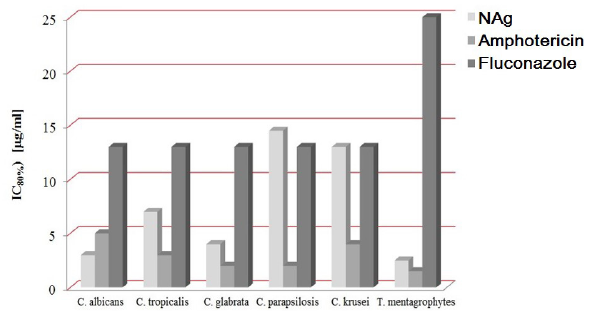
Figure 4: Comparison of antifungal activity of some biocidal factors